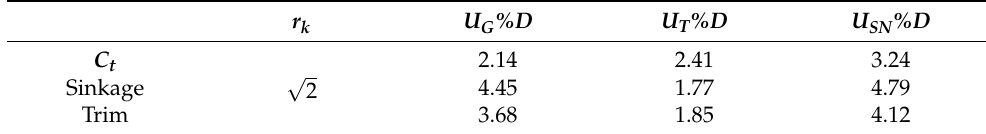
Table 3. Calculation of the numerical uncertainty.